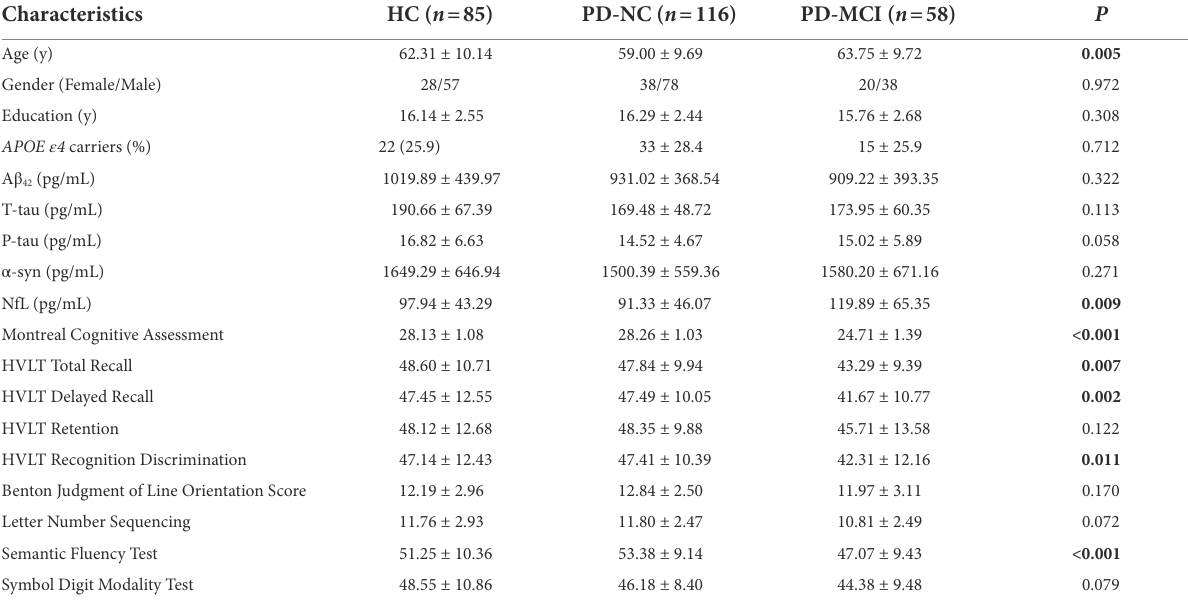
TABLE 1 Baseline clinical information and NfL concentration of participants in this study. Characteristics